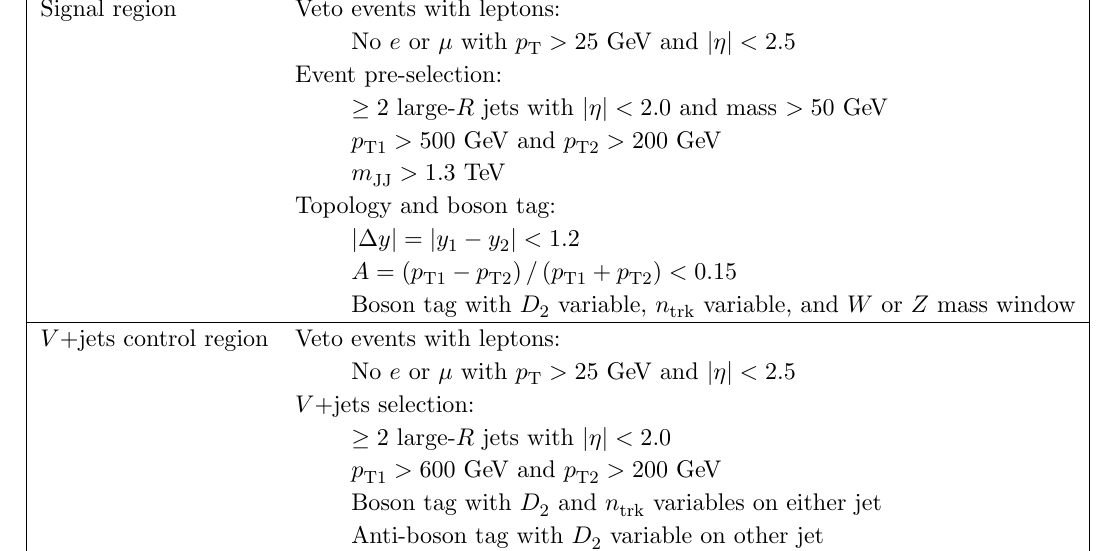
(leading) jet with index 1 and the second T